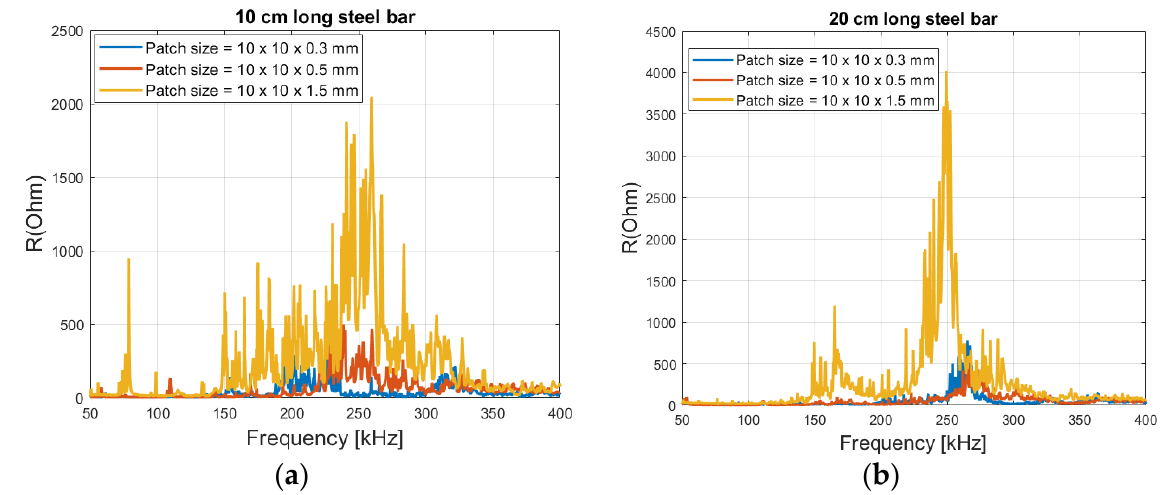
Figure 10. ( a ) The real part of impedance over frequency ranges from 50 to 400 kHz with 10 cm long ( b ) and 20 cm long steel beam in free air.